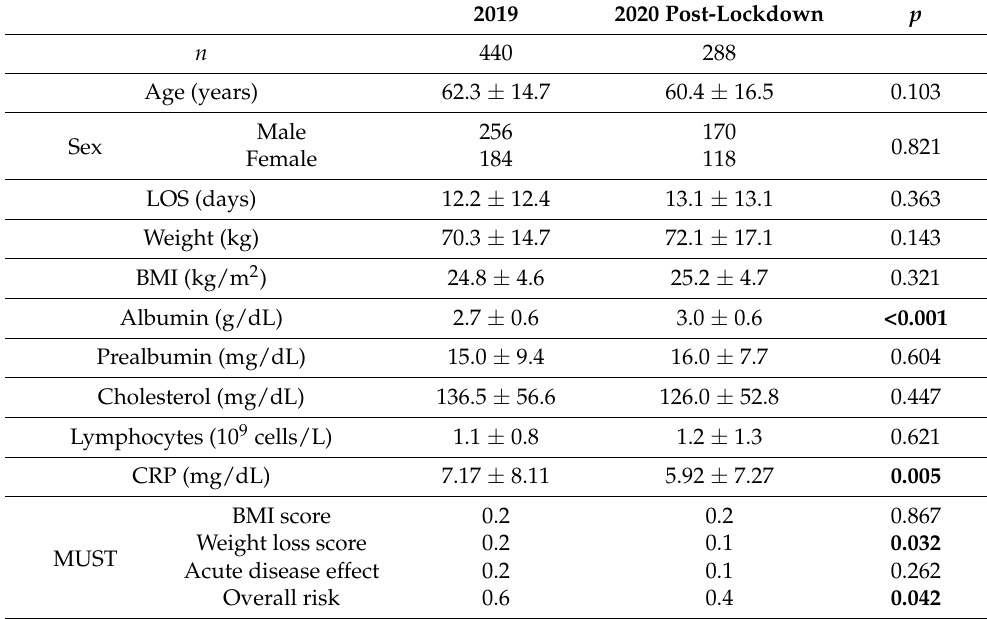
Table 2. Clinical characteristics of patients in the two study periods.